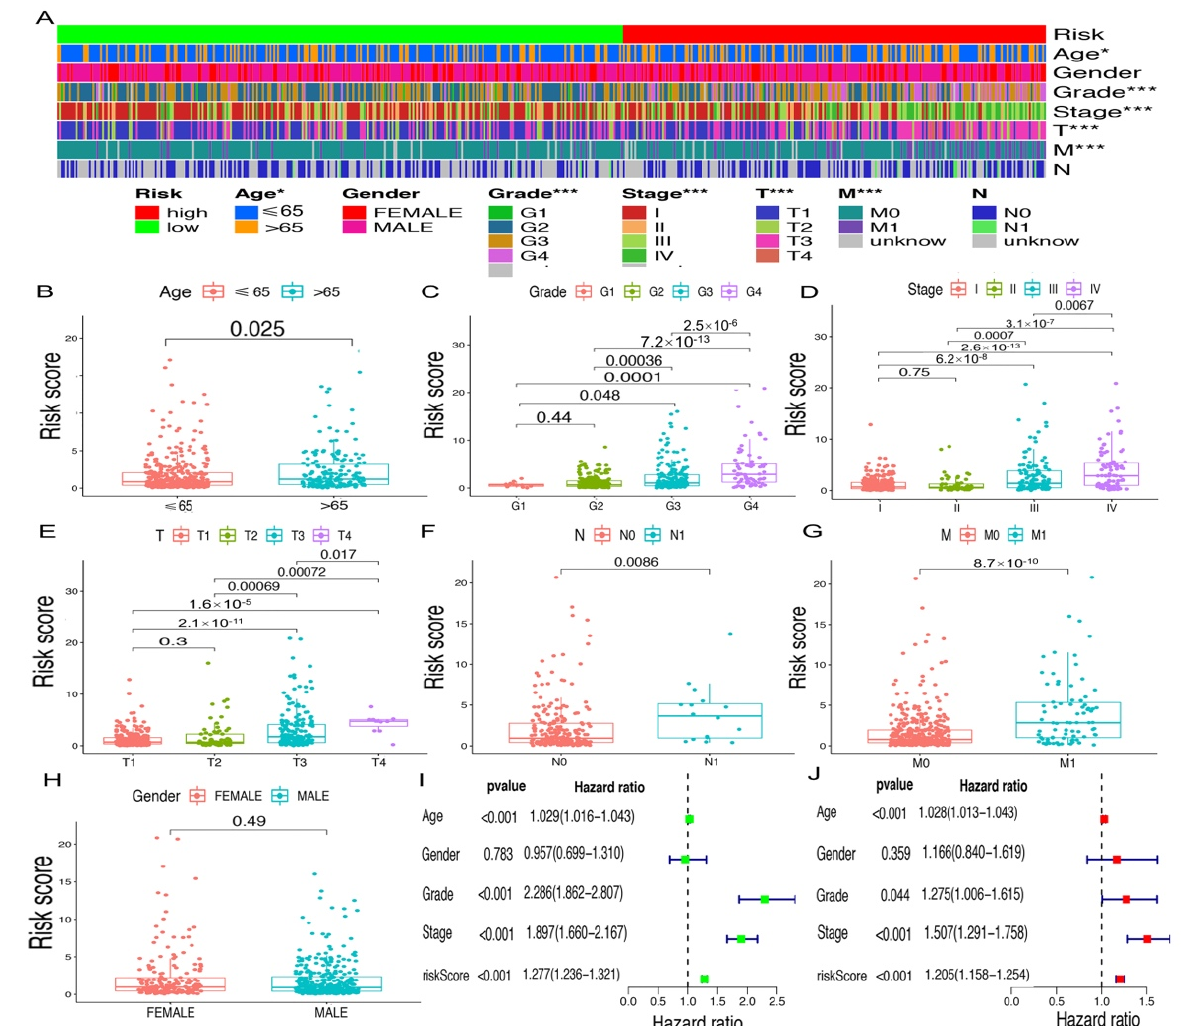
Figure 4. Application of risk assessment model for clinical evaluation. ( A ) Clinical correlation heat map; ( B ) age; ( C ) grade; ( D ) clinical stage; ( E ) T stage; ( F ) N stage; ( G ) M stage; and ( H ) gender. ( I ) The univariate Cox hazard ratio analysis results. ( J ) The multivariate Cox regression analysis results. * p < 0.05; *** p < 0.001.